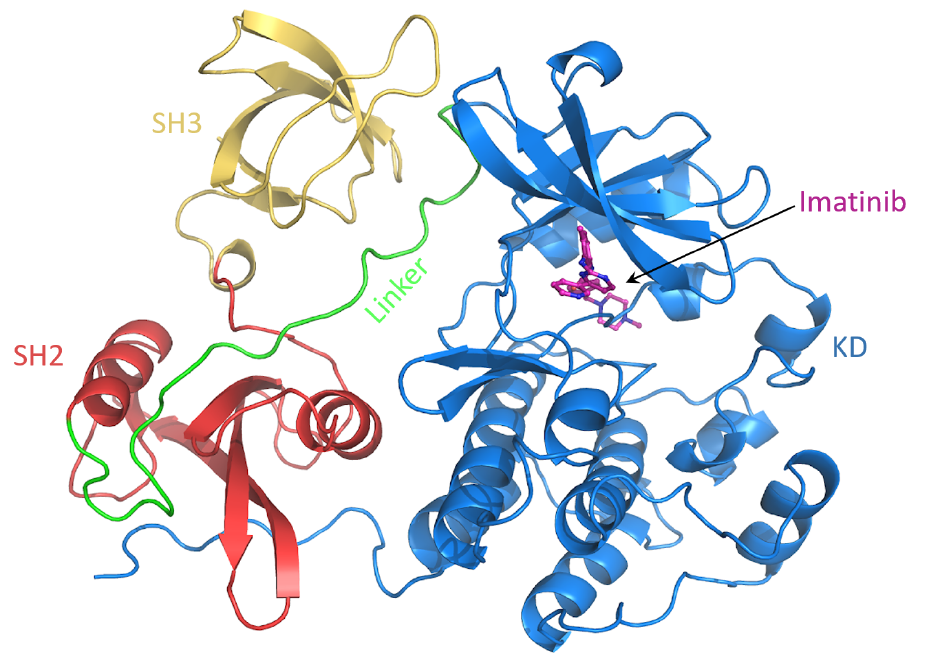
Figure 9. Snapshot of the c-Src–imatinib complex. The domains are